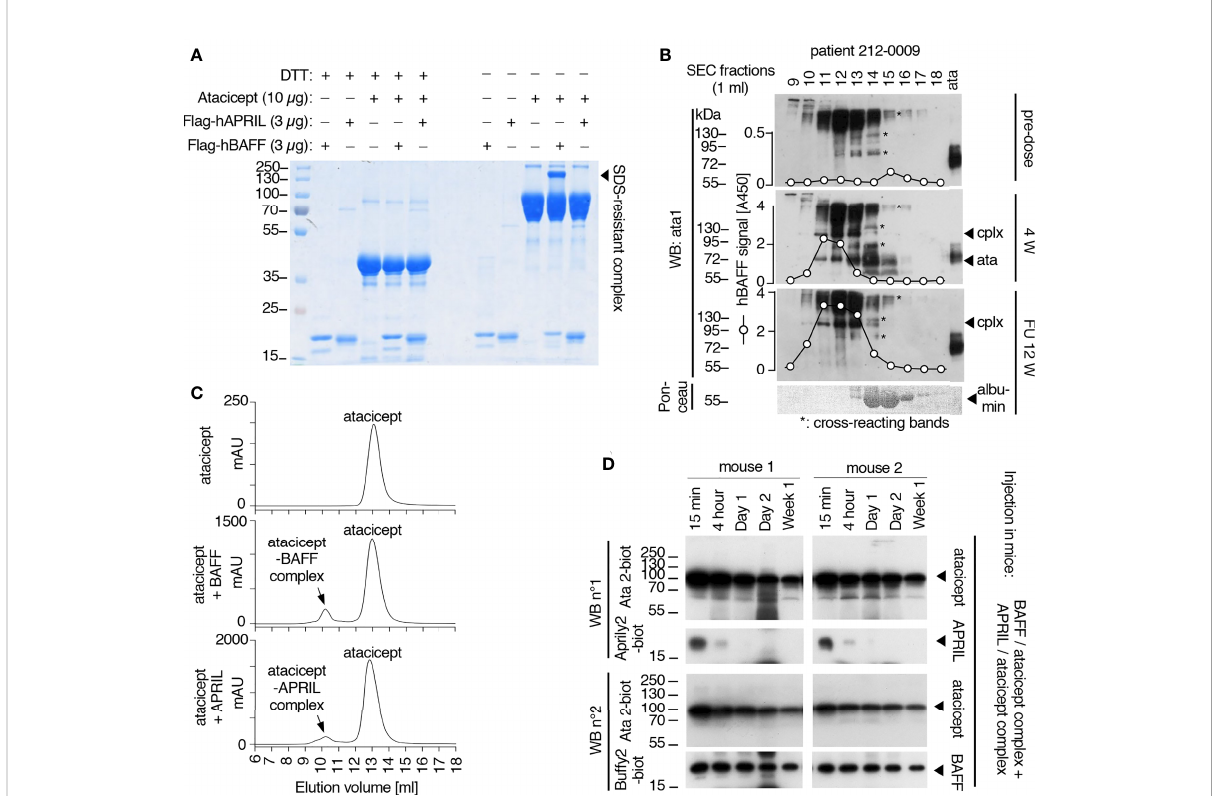
FIGURE 8 Analysis of BAFF/atacicept complex in vitro , in an atacicept-treated human patient serum, and comparison of persistence of BAFF-atacicept and APRIL/atacicept complexes in mice. (A) Puri fi ed Flag-hBAFF, Flag-hAPRIL, atacicept and complexes thereof were analyzed by SDS-PAGE under reducing (+DTT) or non-reducing (-DTT) conditions, followed by Coomassie blue staining. Experiment performed twice in this format, and four times with BAFF. (B) Serum samples from an atacicept-treated SLE patient taken pre-dose, after 4 weeks of treatment (4 W) or 12 weeks after treatment end (FU 12 W) were analyzed by size-exclusion chromatography, followed by Western blot anti-TACI under non reducing conditions. BAFF was also measured in fractions by ELISA. ata: atacicept. cplx: complex ligand-atacicept. “ * ” indicate bands recognized non-speci fi cally in the pre-dose sample, the heaviest being probably human Ig recognized by the secondary antibody. Experiment performed once. (C) Size exclusion chromatography pro fi les of atacicept alone (300 µg) or of puri fi ed Flag-hBAFF or Flag-hAPRIL mixed with a 20-fold mass excess of atacicept to create and isolate atacicept/BAFF and atacicept/APRIL complexes for administration in mice. (D) Puri fi ed atacicept/BAFF and atacicept/APRIL complexes of panel B were co-administered in two wild type mice. Serum samples collected at the indicated time points were analyzed by Western blot under non-reducing conditions, once for the presence of atacicept and human APRIL and once for the presence of atacicept and human